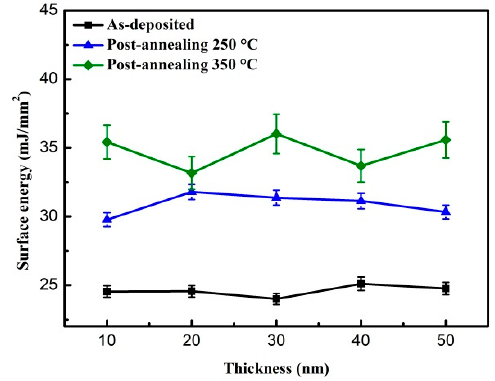
Figure 4. The surface energy of CoFeW thin films.